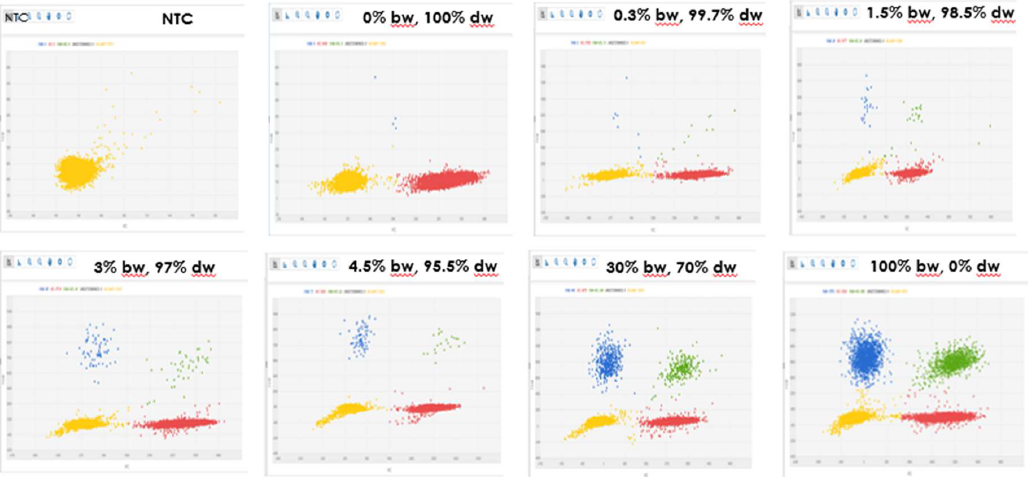
Figure 2. Two-dimensional scatter graphs generated by chip digital PCR (cdPCR) analysis of eight different samples. NTC (No Template Control) is a blank sample without DNA; The other samples are made of durum wheat (dw) DNA or common wheat (bw) DNA or a mix of the two, as indicated in the figure; In this graph a partition can fall into one of four possible clusters: negative partition that contain no amplified targets (yellow), single positive partition for Triticum genus (red), single positive partition for common wheat (blue) and positive partitions that contain a positive signal for both targets (green, double-positive partitions).